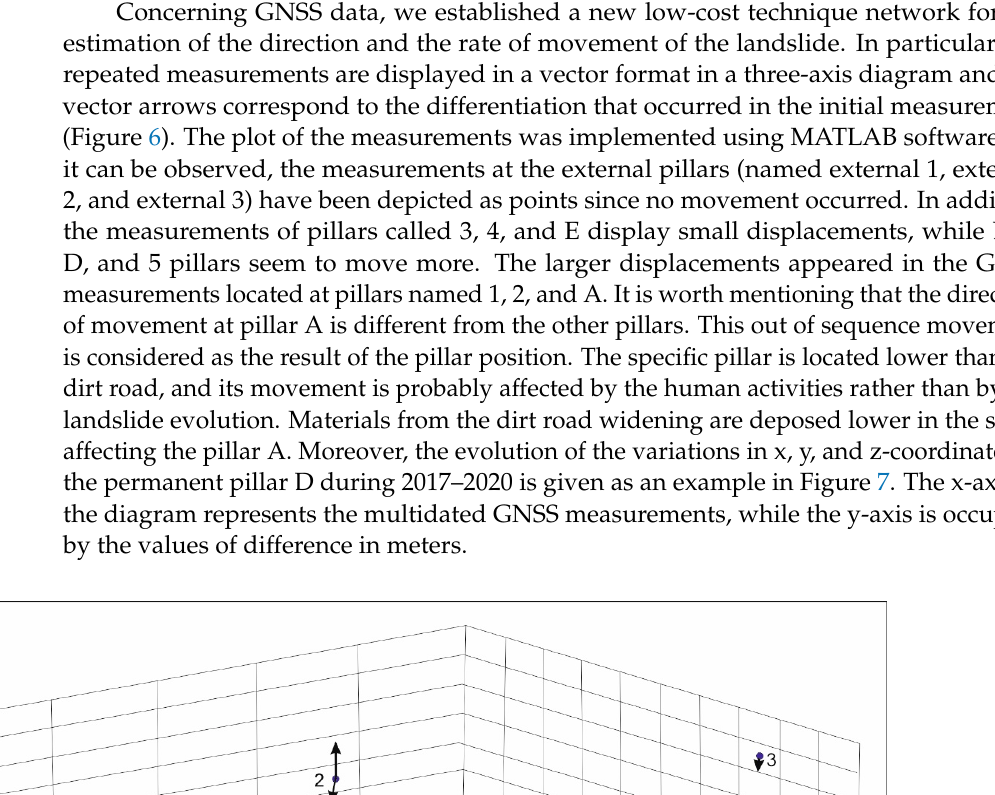
Figure 7. A polar network presenting the evolution of the displacements of the permanent pillar D during 2017–2020. 4. Results 4.1. Mapping